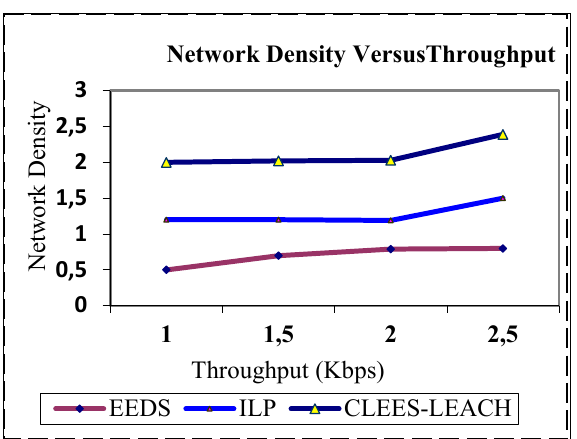
Figure 13. Comparison Graph for Throughput for